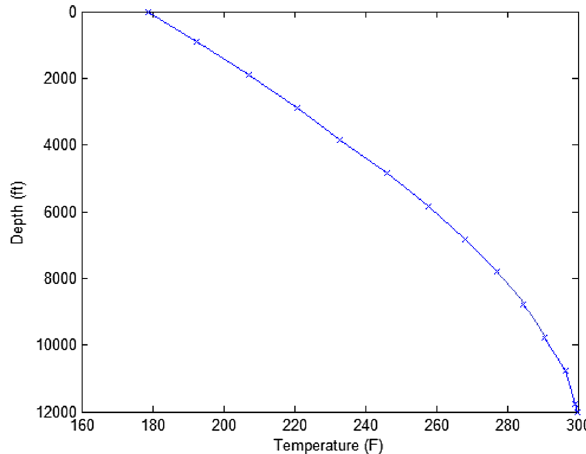
Fig. 7 Fluid density profile in the well for choke size of 44/64 inches